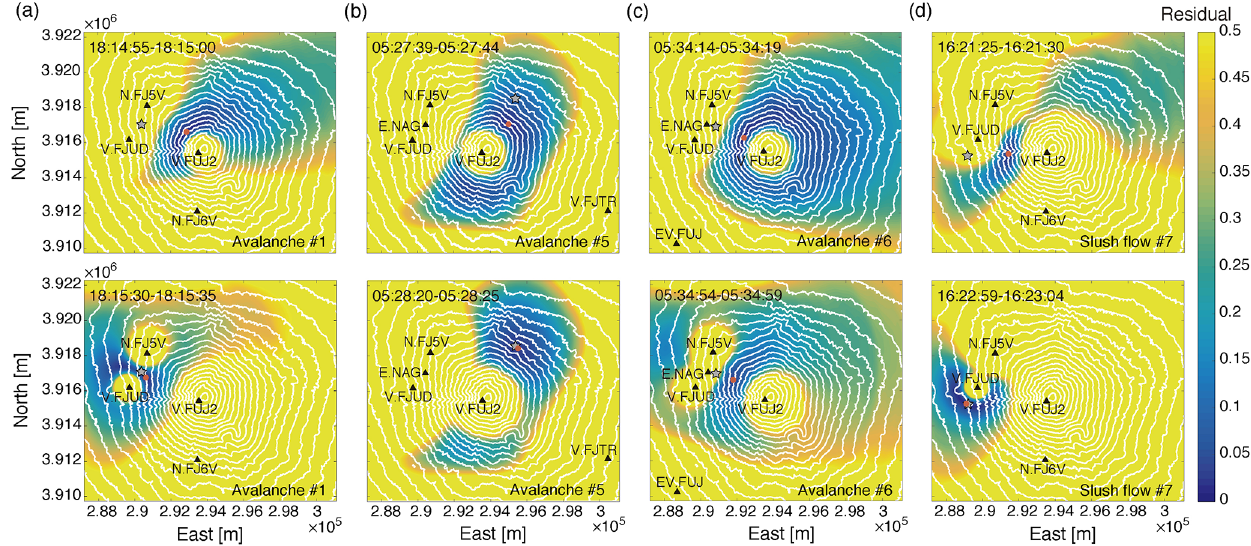
Figure 6. Maps of the spatial distributions of the residuals estimated for (a) avalanche #1, (b) avalanche #5, (c) avalanche #6, and (d) slush flow #7 at two different times: at the beginning of seismic tracking ( t 1 ; upper panels) and at maximum source amplitude of the flows (lower panels). The asterisks mark specific locations of the run-out area of each flow: the road for avalanches #1 and #5, the dam for avalanche #6, and the video camera for slush flow #7. The red dots indicate the locations of minimum residual at the given instant.